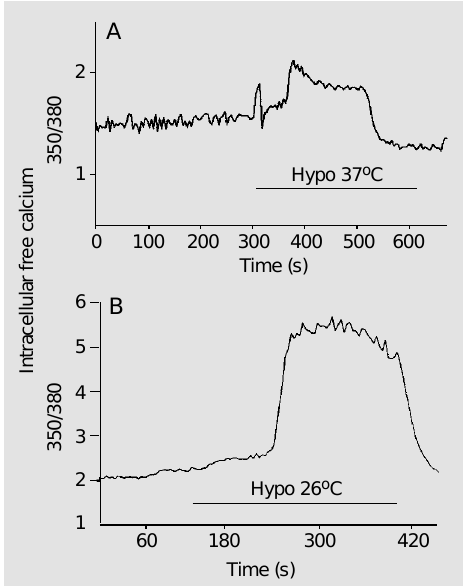
Figure 2 - Intracellular free Ca 2+ measurements expressed as fluorescence ratio. Representa- tive experiments showing Ca 2+ transient increases in hypos- motic solutions (hypo) at 37 o C (A) and 26 o C